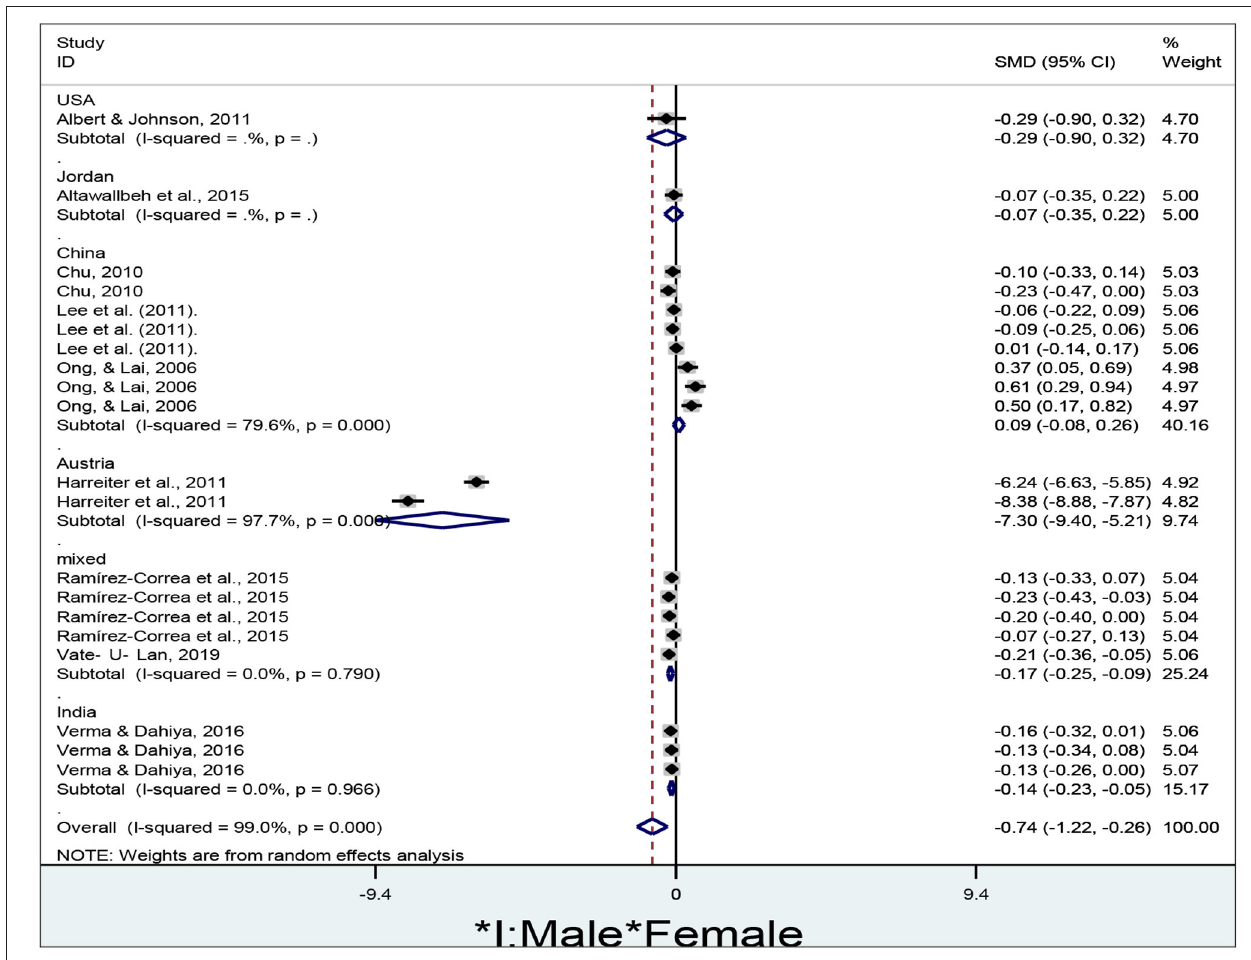
FIGURE 8 | Gender differences in e-learners’ attitude in different